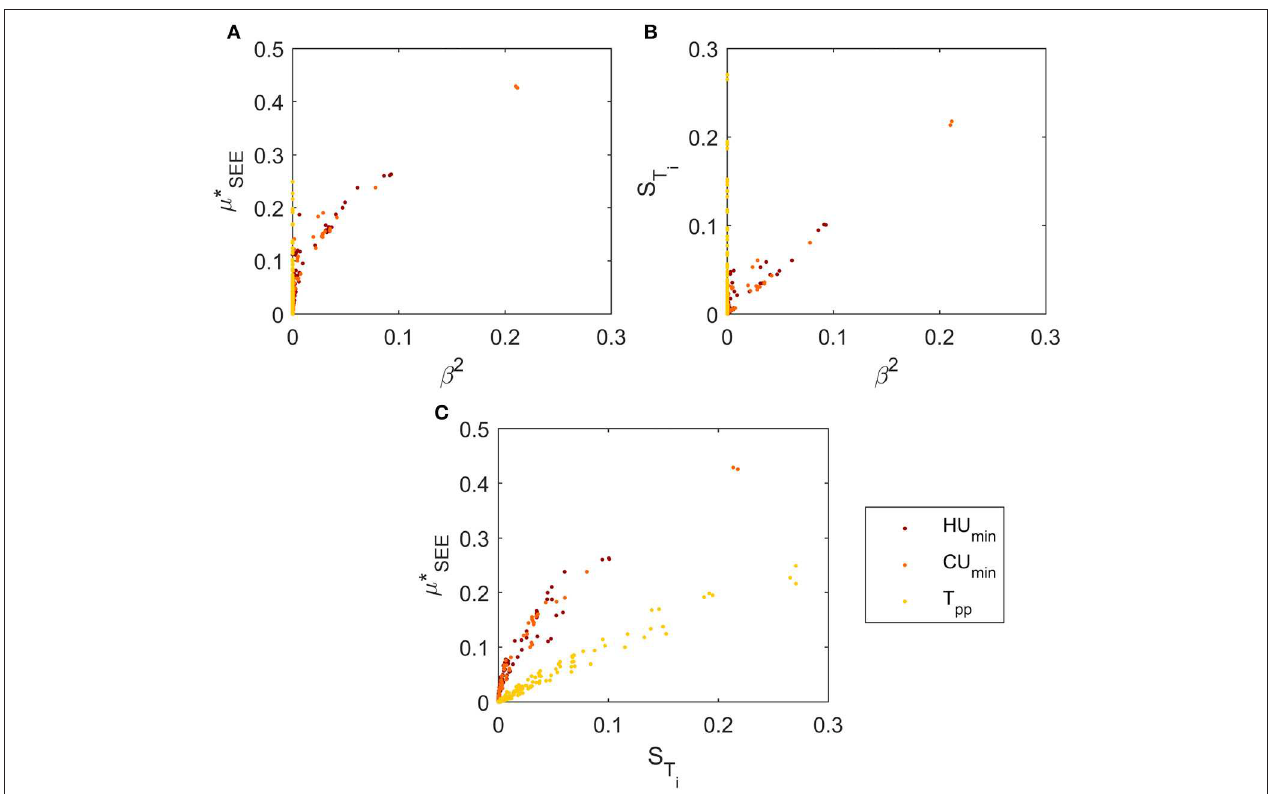
FIGURE 8 | Comparison of sensitivity indices for the k = 205 parameters. (A) β 2 vs. µ ∗ SEE , (B) β 2 vs. S T